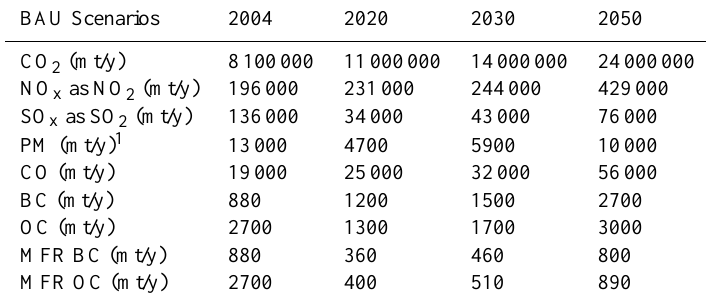
Table 8. Summary of in-Arctic emissions inventories for 2004 and BAU projections.